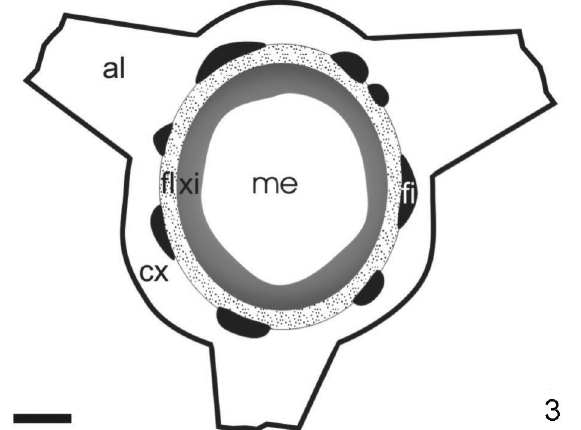
FIGURA 3 – B. microcephala – Diagrama da secção transversal do cladódio. al: ala; cx: córtex; fi: fibras esclerenquimáticas; fl: floema; me: medula; xi: xilema. Barra = 100 µ